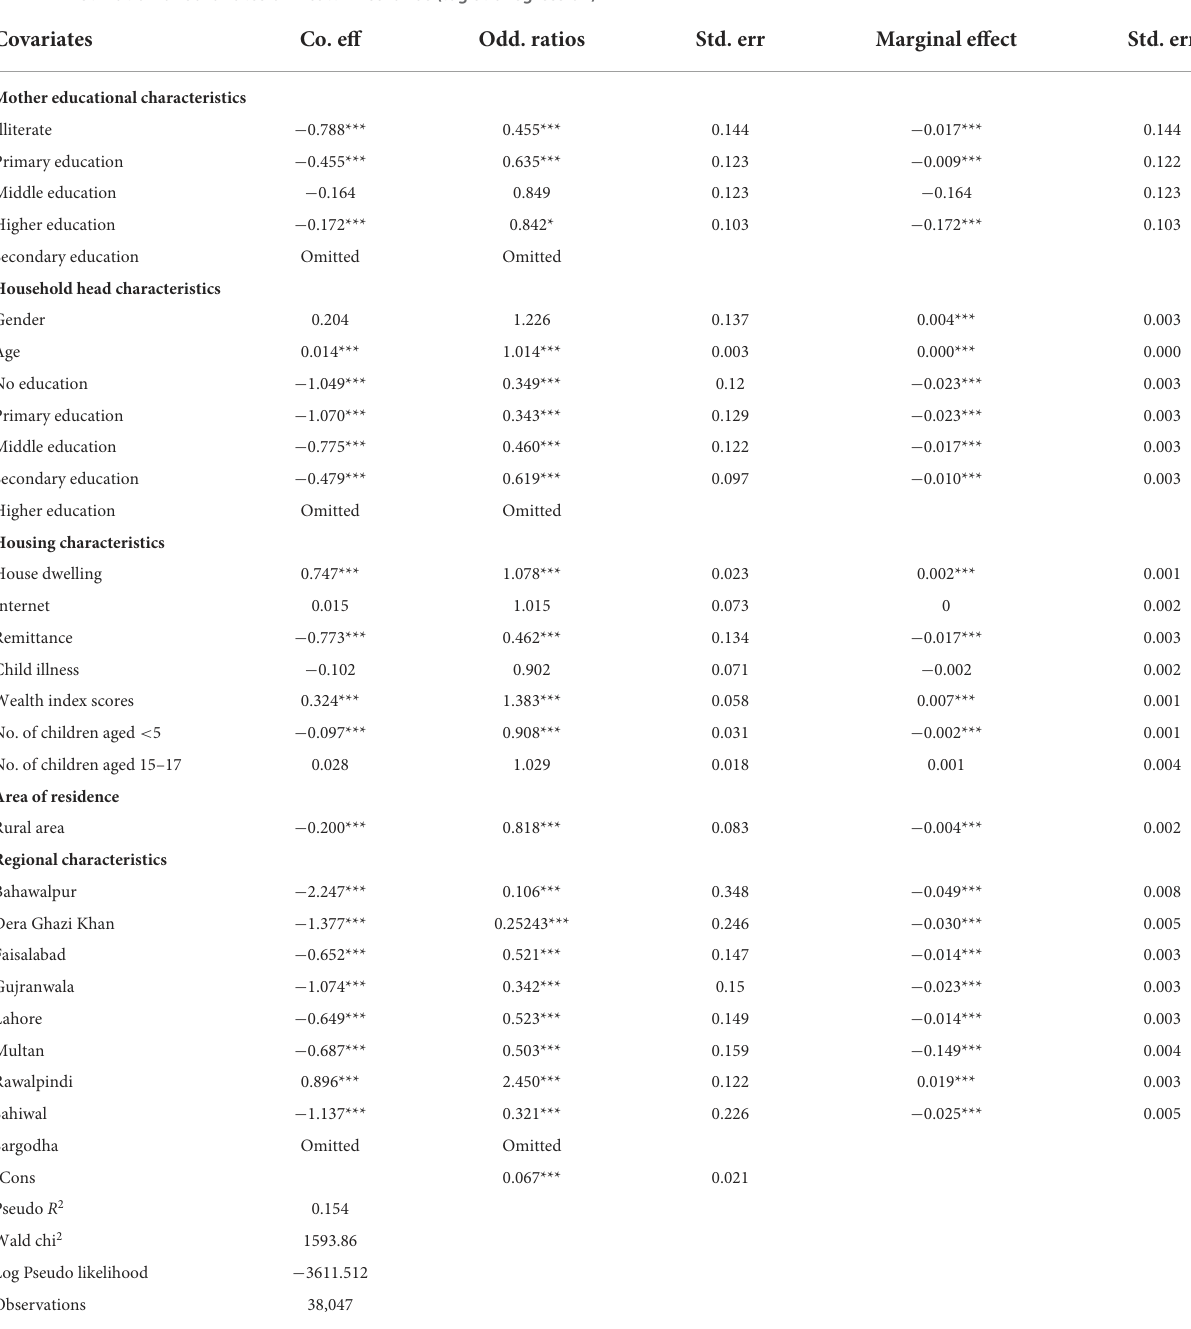
TABLE 1 Estimation of covariates on health insurance (logistic regression). Covariates Co. eff Odd. ratios Std. err Marginal effect Std.